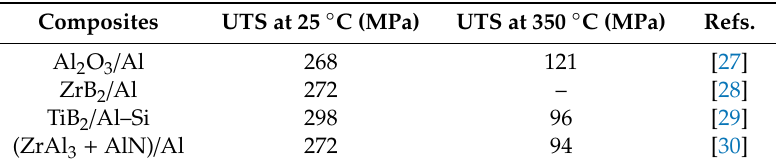
Table 2. Comparison of the tensile properties of several